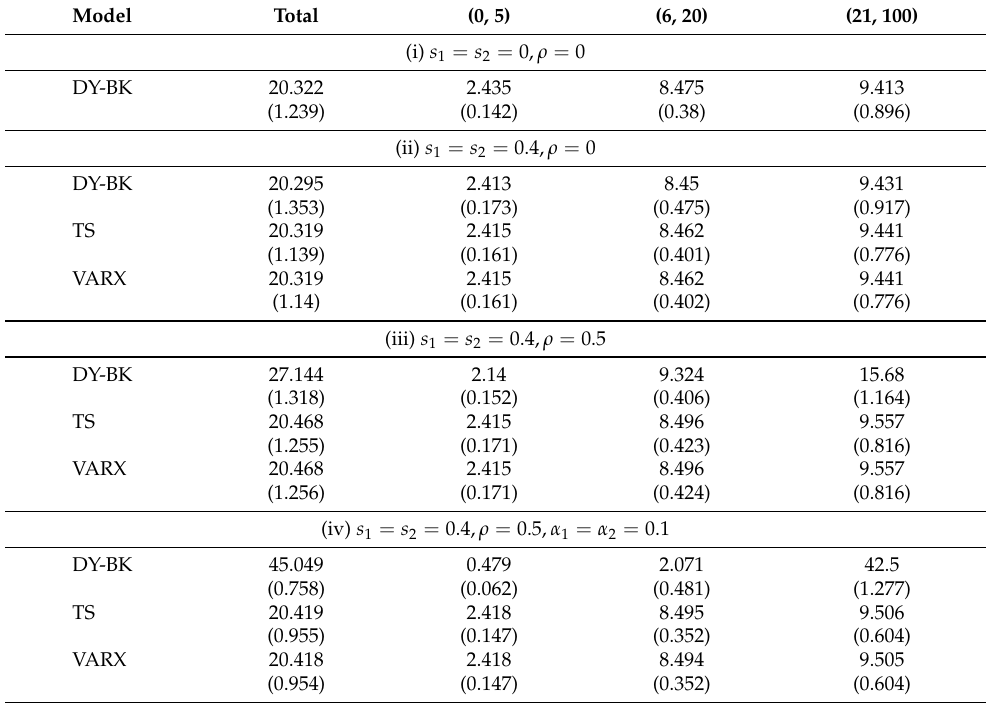
Table A1. Simulation